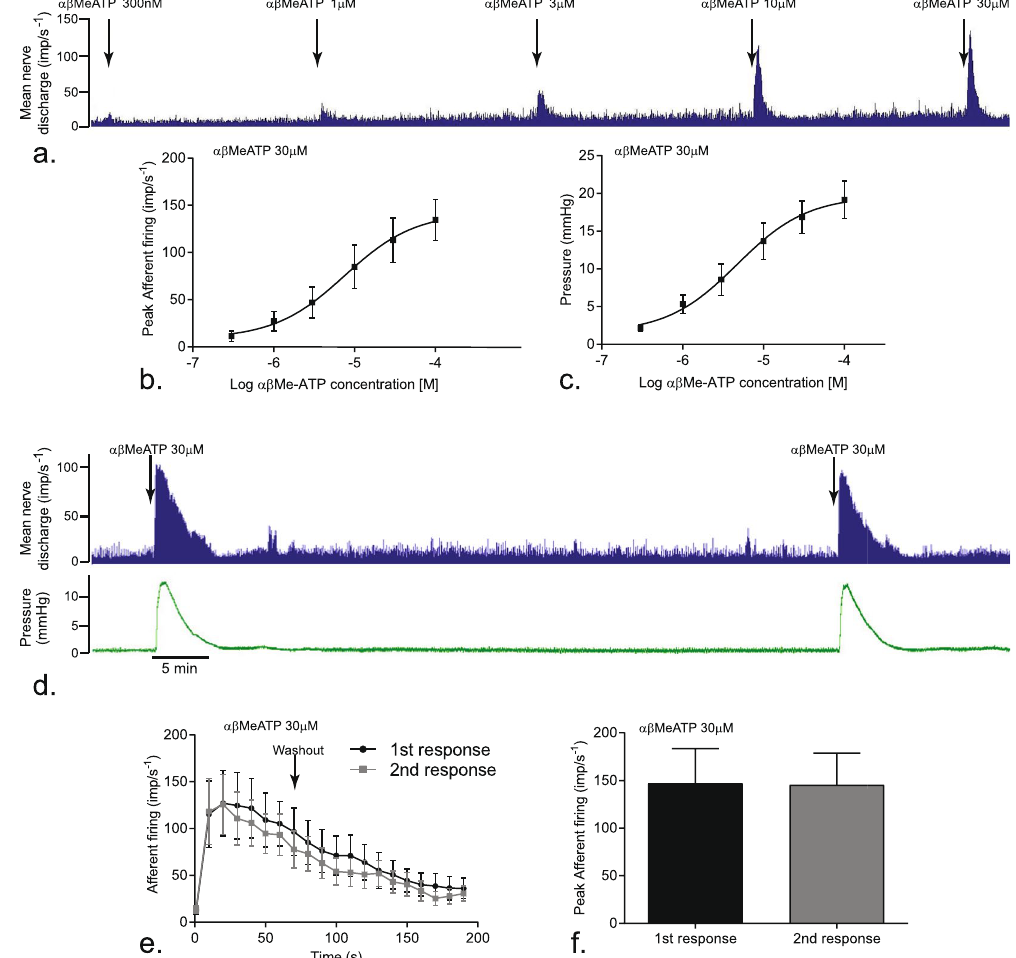
Figure 1. Bladder afferent nerves respond to αβ Me-ATP. ( a ) Experimental trace of afferent nerve activity in response to increasing concentrations of αβ Me-ATP applied for 60 s before washout; ( b ) concentration- response curve of afferent nerve activity to αβ Me-ATP; ( c ) concentration-response curve of intravesical pressure (contraction) to αβ Me-ATP; ( d ) afferent nerve and intravesical pressure responses to repeat applications of αβ Me-ATP (30 µ M); ( e ) afferent nerve time course response to repeated applications of αβ Me- ATP (30 µ M) applied for 60 s before washout; ( f ) peak afferent firing in response to repeat application of αβ Me- ATP (30 µ M). Data shown are mean ± SEM (n =